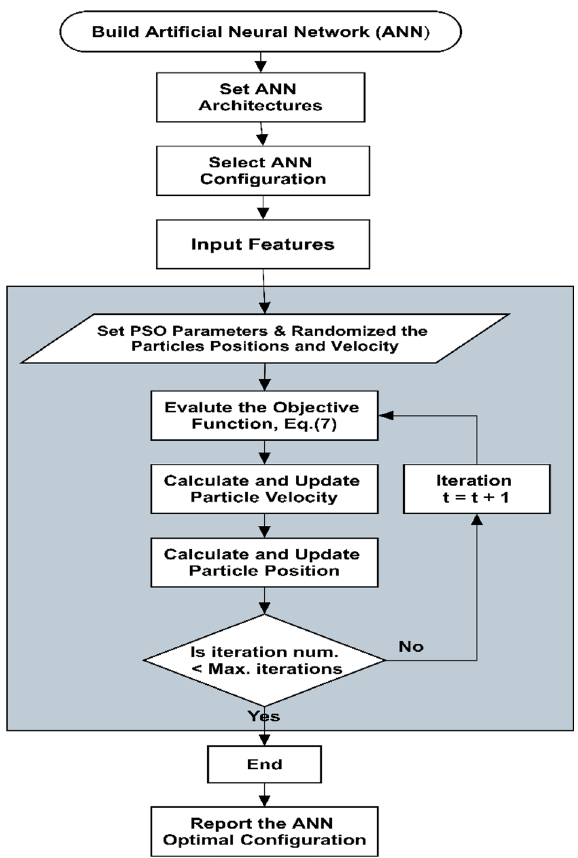
Fig. 7 The process of optimizing ANN configuration from the scope of